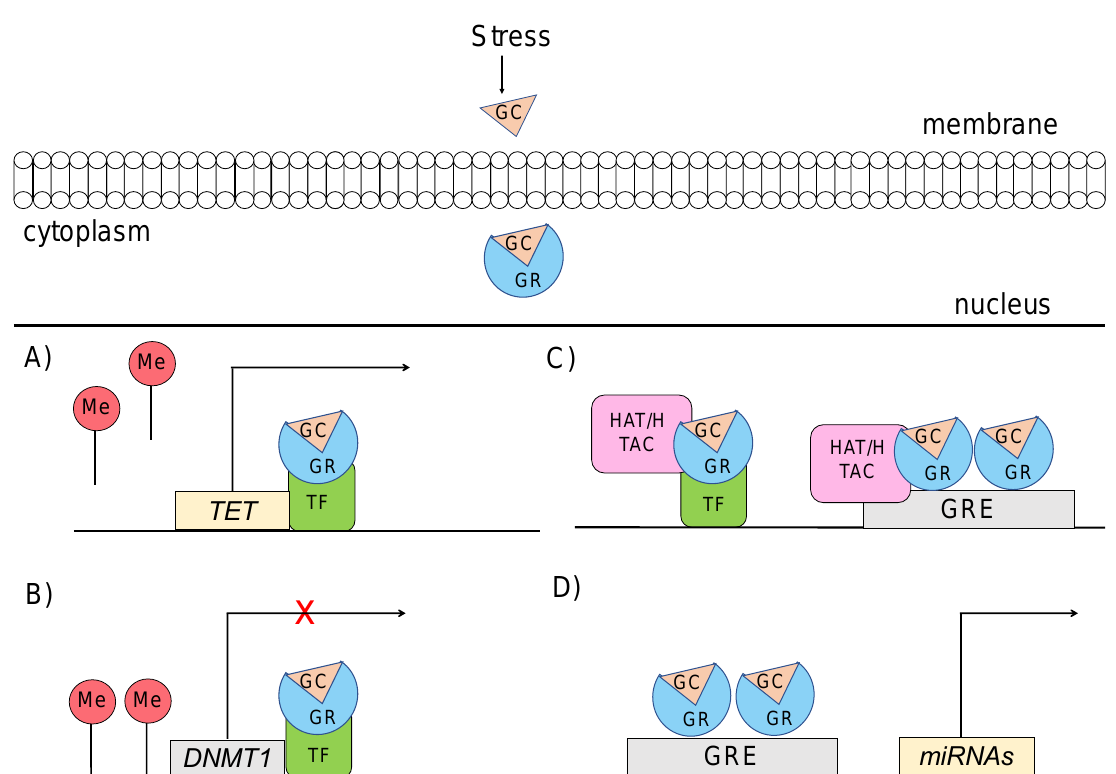
Figure 3. Mechanisms through which glucocorticoid-mediated activation of GR can induce epigenetic changes ( A ) GRs through interaction with transcription factors (TF) catalyze active demethylation of enzymes involved in demethylation processes, such as the TET family of 5-methylcytosine dioxygenases. ( B ) GRs catalyze active methylation of enzymes involved in methylation processes, such as DNMT (DNA methyltransferase 1, DNMT1). ( C ) GRs activation can induce histone modifications via direct GR binding on GRE elements or via interaction of GRs with TFs that recruit histone acetyl- transferases. ( D ) GRs activation can regulate the expression of microRNAs, enriched in GRE elements. GC: glucocorticoid, GR: glucocorticoid receptor, GRE: glucocorticoid response elements, DNMT1: DNA methyltransferase 1, HAT: histone acetyltransferases, HDAC: histone deacetylase, ME: methionine, TET: ten-eleven translocation methylcytosine dioxygenases, TF: transcription factor.